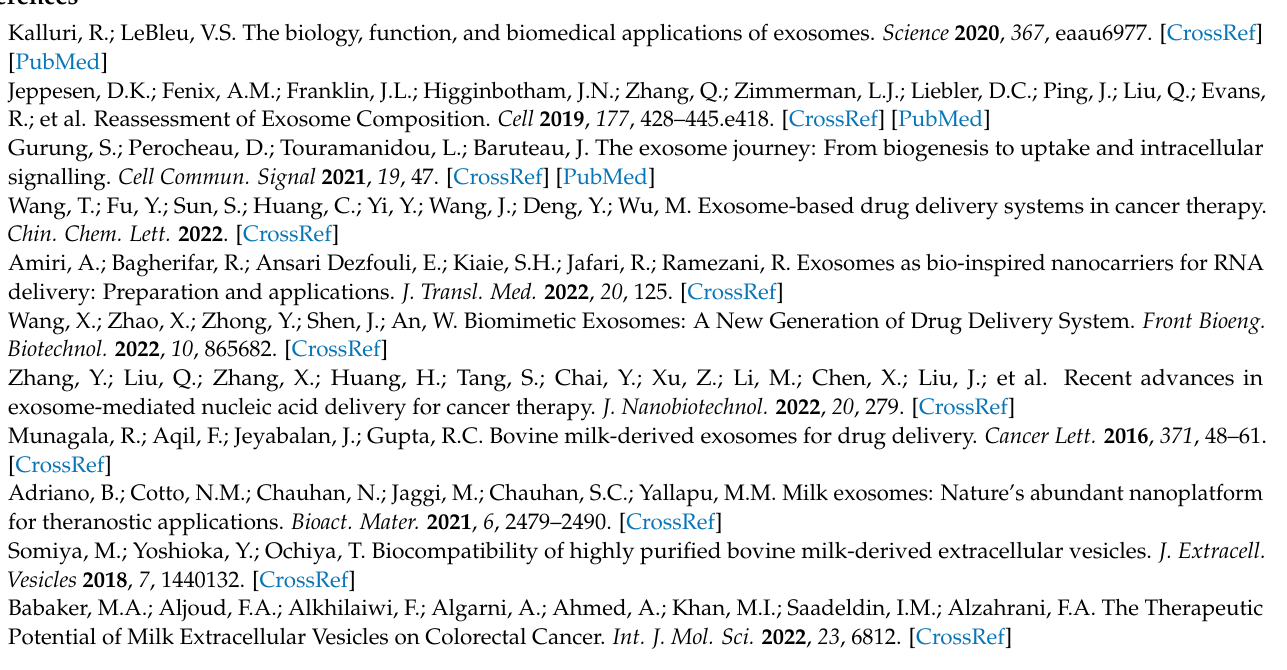
Figure S1: Standard curve of miR-204 concentration versus the corresponding fluorescence intensity; Figure S2: Agarose gel electrophoresis of free miRNA-204 and mExo-miR204; Figure S3: Storage stability of HA-mExo-miR204; Figure S4: CD44 expression in cancer cells; Figure S5: Western blotting analysis of RAB22A expression; Figure S6: The effect of HA-mExo-miR204 on the chemosensitivity of Dox; Figure S7: Body weight and tumor weight of mice; Figure S8: Cytotoxicity of DSPE-PEG 2000 -HA, mExos and HA-mExos; Figure S9: In vitro hemocompatibility of mExos and HA-mExos; Figure S10: In vivo distribution of mExos and